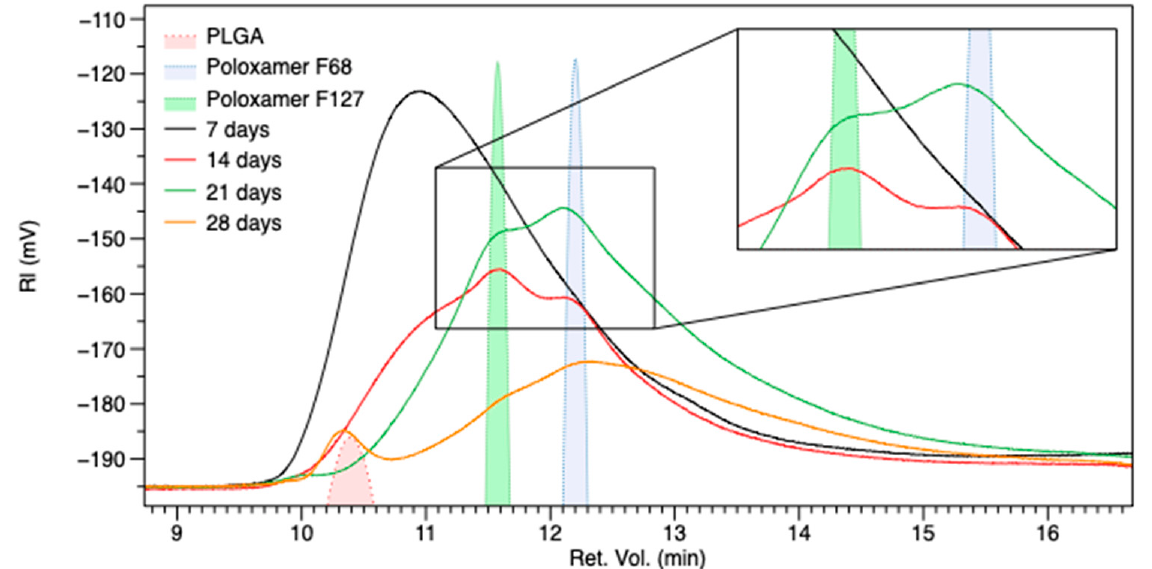
Figure 6. Superimposed chromatograms at RI detector of 24:70 series and in full red pure PLGA, in full green F127 POLOX, in full blue F68 POLOX. Chromatograms from 14 days show the presence of poloxamers and, at 28 days, a residual peak of PLGA.